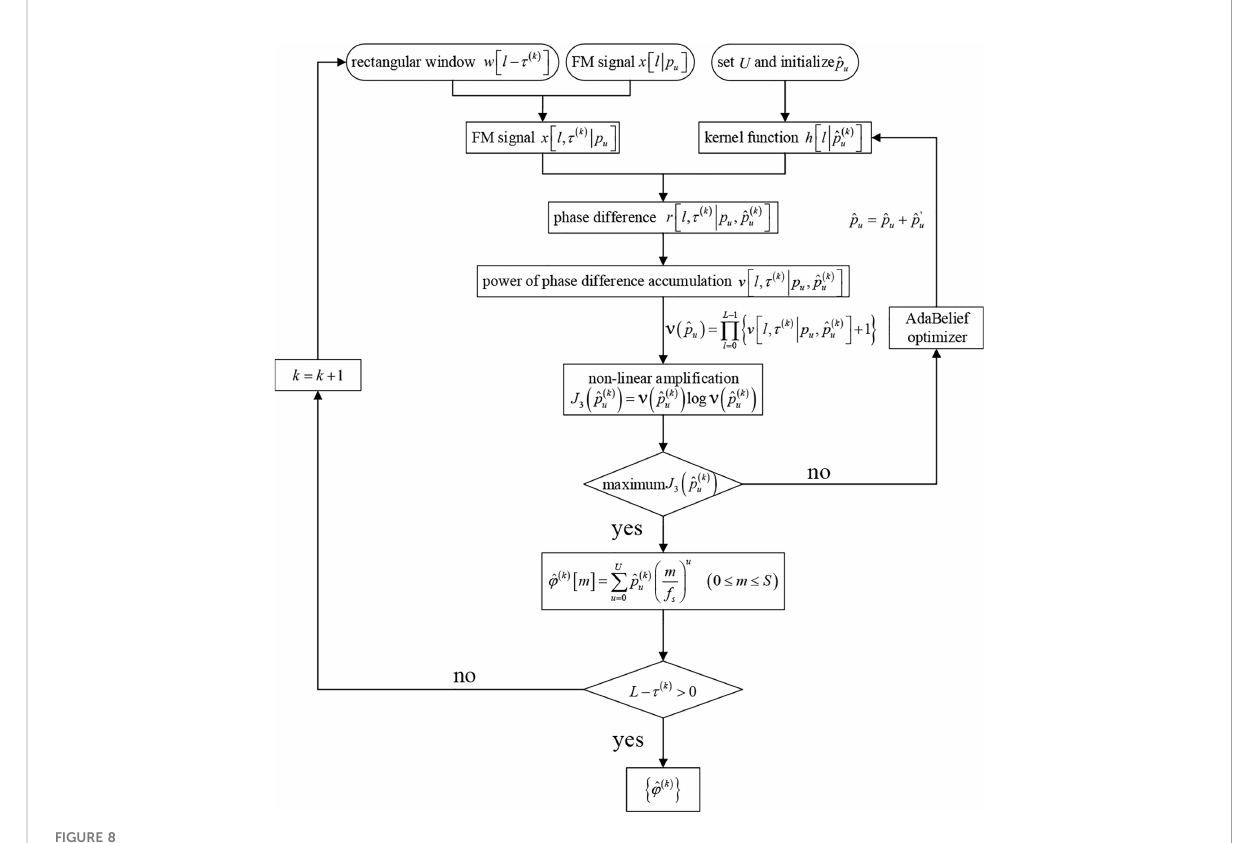
FIGURE 8 Time – frequency estimation based on